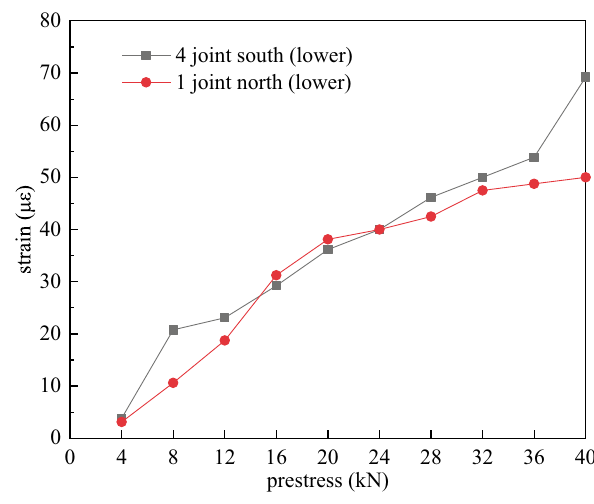
Fig. 24 Micro strain comparison